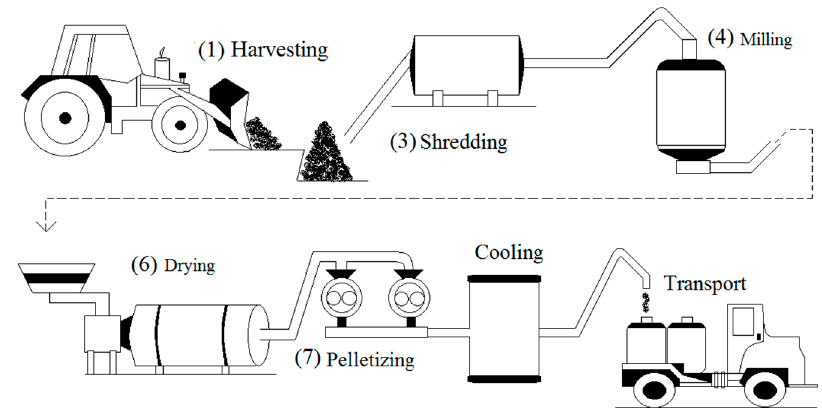
Figure 7. General wood pellet manufacturing process in Agrep Forestal S.A., established in Costa Rica [136].